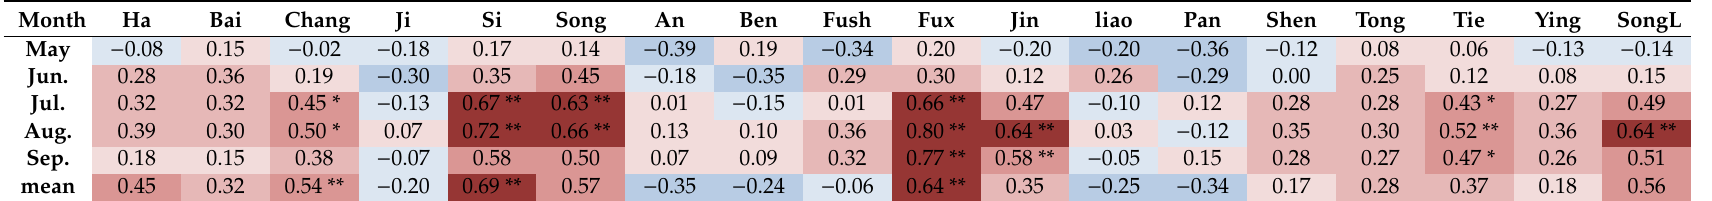
Table 5. Pearson correlation coe ffi cient of SPEI-3 and climate yield in the maize growing season in the Songliao Plain maize belt during the period